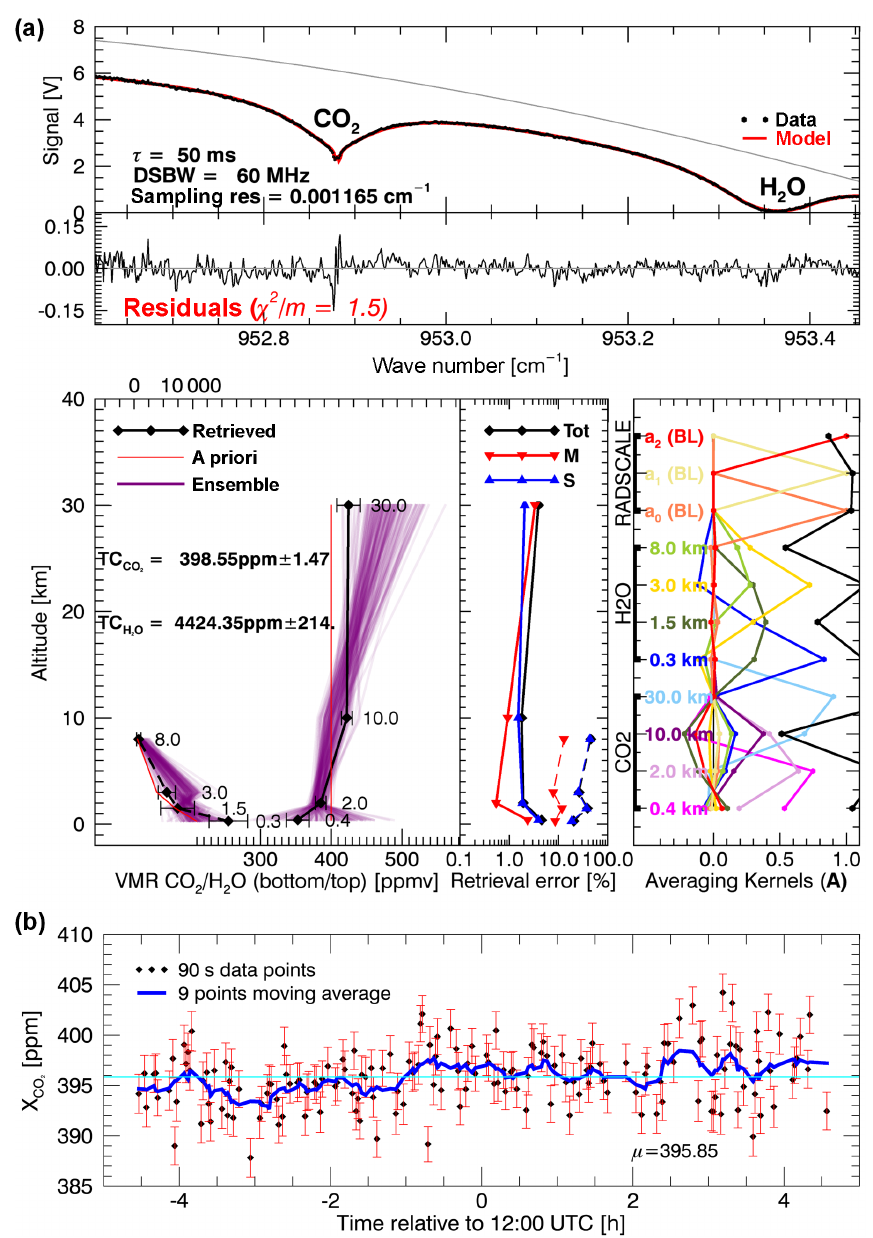
Figure 9. Retrieval results for measurements acquired on 30 June 2016 at 60MHz spectral resolution; only the 166 out of 455 retrievals that converged within 10 iterations and where χ 2 / m < 2 have been retained. (a) Same as Fig. 2 but for real data and with different prior conditions (see text). Purple profiles correspond to the ensemble of retained inversions (CO 2 on the right, H 2 O on the left); the selected profile (black with error bars corresponding to the retrieval uncertainty) corresponds to a measurement at 12:05UTC. The top panel shows the measured spectrum (data) with a superimposed retrieved spectrum (model), and the difference is shown as residuals below. The estimated total columns (TC) with uncertainties are given as text. Total retrieval errors (Tot) and contributions from measurement noise (M) and smoothing error (S) are shown as profiles in the centre (solid line for CO 2 , broken line for H 2 O). The averaging kernels for the composite state vector are shown on the right. The partial DFS in this retrieval configuration, averaged over the series, are 2.4 for CO 2 and 2.0 for H 2 O. RADSCALE denotes the instrument baseline (BL); (b) associated daily evolution of X CO and moving average computed over the individual 2